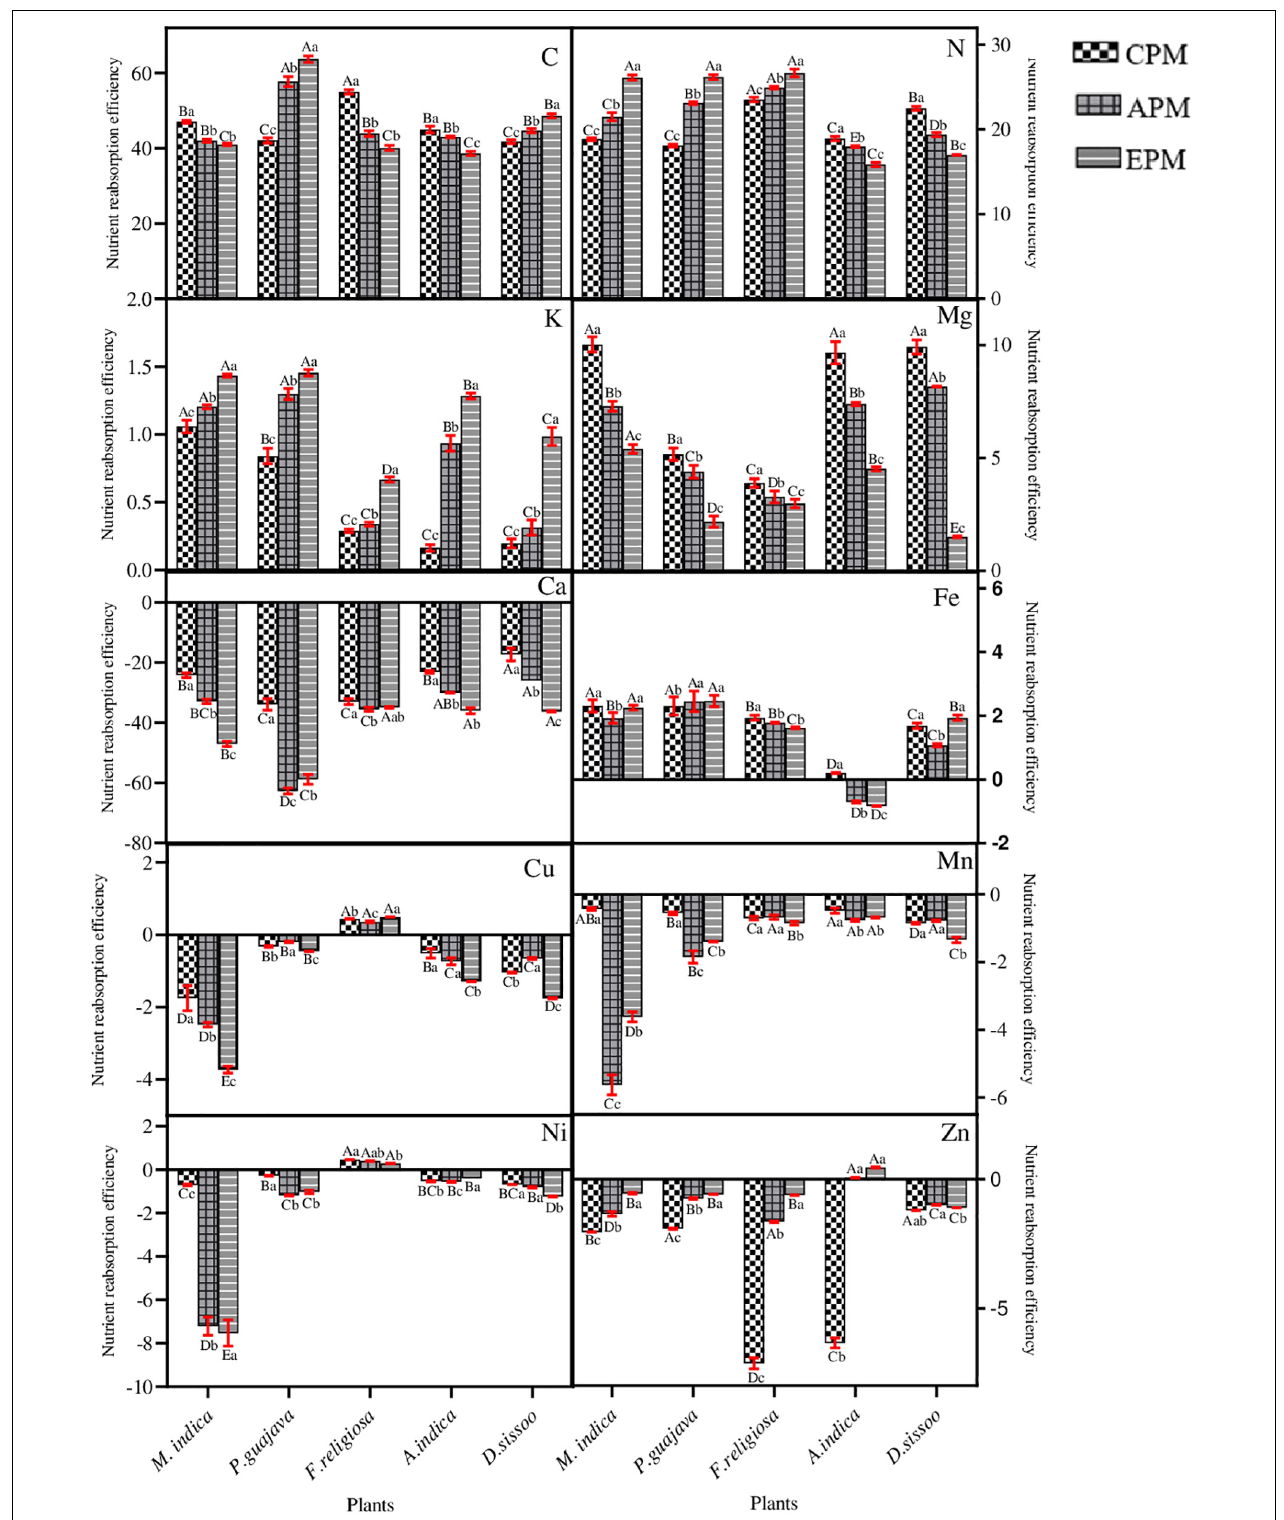
FIGURE 5 | The nutrient re-translocation efficiency of different tree species under different PM treatments. Different letters in uppercase indicate a significant difference between PM treatments for different trees ( p < 0.05) and different lowercase letters indicate a significant difference between the treatment with species ( p <